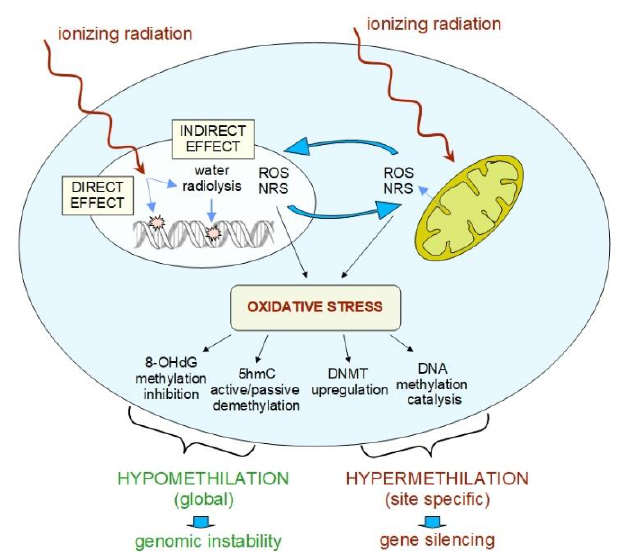
Figure 2. Simplified representation of the role of reactive oxygen species (ROS) and reactive nitrogen species (RNS) in the epigenetic response (DNA methylation) to ionizing radiation. Ionizing radiation can cause DNA lesions by direct deposition of energy in the DNA as well as by the indirect action of reactive chemical species formed near the DNA. Indirect DNA damage arises from free radicals formed through the radiolysis of water molecules. In aerobic conditions, these free radicals are converted to reactive oxygen species (ROS). Ionizing radiation can also generate reactive nitrogen species (RNS) through the upregulation of several enzymes. The yield and spatial distribution of ROS and RNS are strongly modulated by radiation quality because of the specific track structure of each quality [113]. ROS and RNS can attack DNA, resulting in several alterations that, if unrepaired or mis-repaired, may lead to genetic mutations in surviving cells. In addition, they can drive various epigenetic modifications through several mechanisms. It was demonstrated, especially in fibroblasts [114], that ROS can be directly generated by radiation exposure and indirectly through the radiation damage of mitochondria, leading to the activation of signaling pathways, which in turn sustains an increase in ROS levels. Oxidative stress results when excess of ROS / RNS are not compensated by the scavenging mechanisms of the cell. DNA hypomethylation can be achieved by oxidation of guanine to 8-OHdG that inhibits DNA methylation at nearby cytosine bases, and by hydroxylation of 5 mC to 5 hmC that causes active DNA demethylation processes. ROS can also induce site-specific DNA hypermethylation by up-regulation of expression of DNMTs or by acting as catalysts of DNA methylation [126]. Oxidative stress can influence the epigenetic landscape of the cell on other levels, such as by histone modifications and miRNA expression (not shown here).